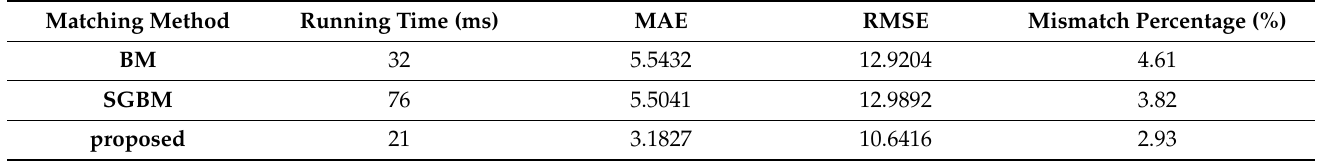
Table 1. Comparison of matching